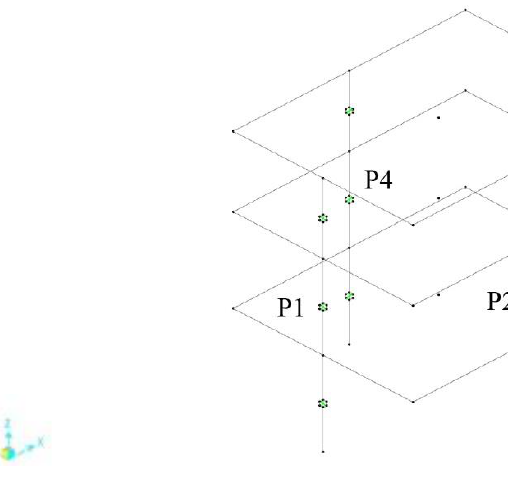
Figure 8. Axonometric view of the simplified 3D model for the Push-Over (PO) analysis of the case-study Blockhaus system (SAP2000 [35]).